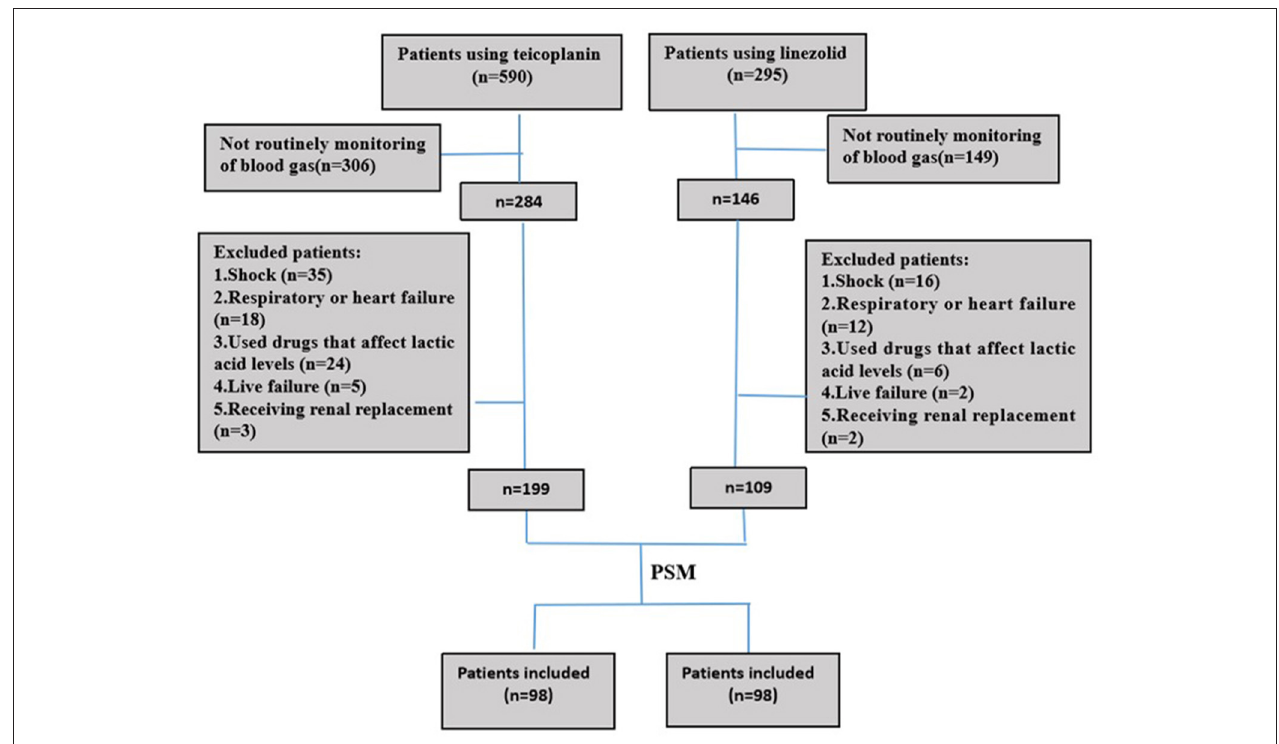
FIGURE 1 | Screening of patients using teicoplanin or linezolid during the study